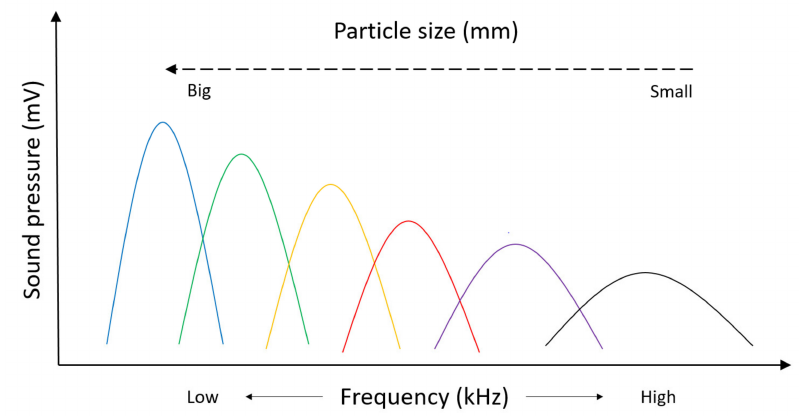
Figure 5. Sound-pressure and frequency characteristics by particle sizes.